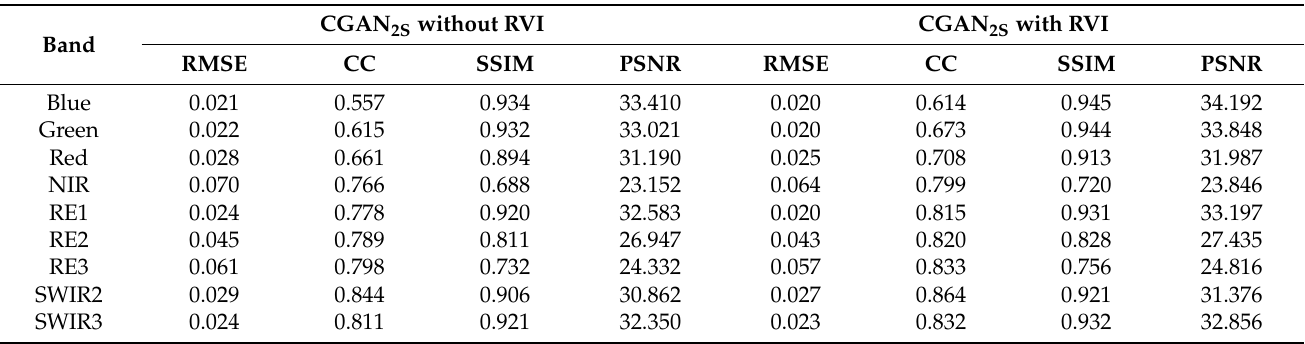
Table 8. Accuracy statistics for different SAR feature combinations (RE: red-edge; NIR: near infrared; SWIR: shortwave infrared; RMSE: root mean square error; CC: correlation coefficient; SSIM: structural similarity; PSNR: peak signal-to-noise